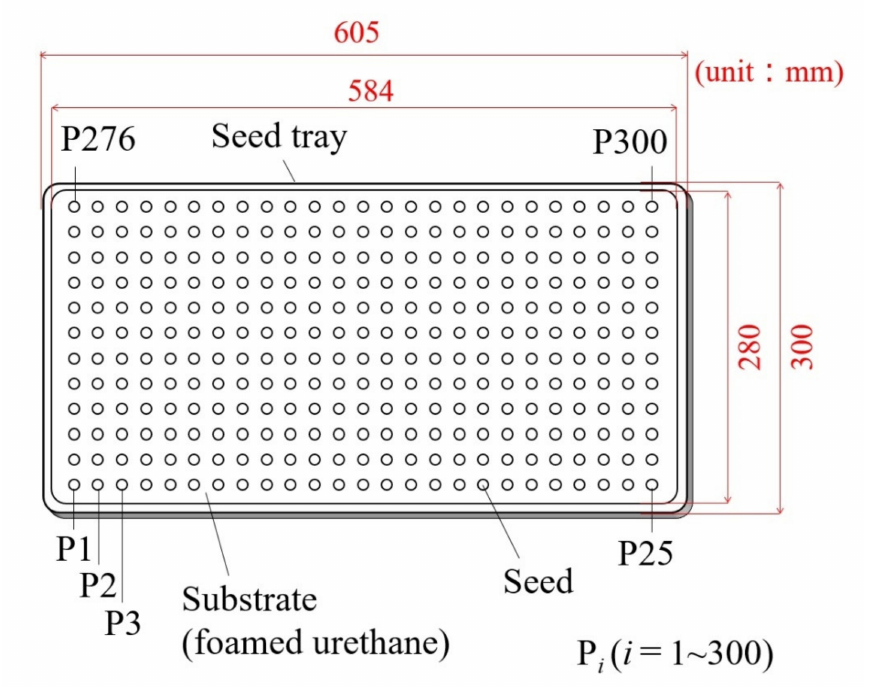
Figure 2. Plane view of seed tray with substrate consisting of 300 ( = 25 × 12) foamed urethane cubes. All seeds in each tray are numbered in accordance with the position in the seed tray with plant seed number (P i (i =